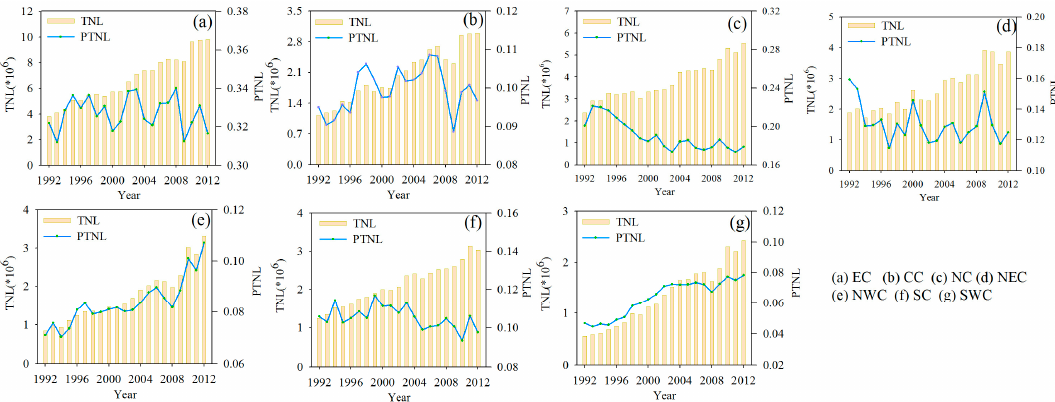
Figure 8. Nighttime light pollution at the regional scale in China. ( a ) EC; ( b ) CC; ( c ) NC; ( d ) NEC; ( e ) NWC; ( f ) SC; ( g ) SWC.